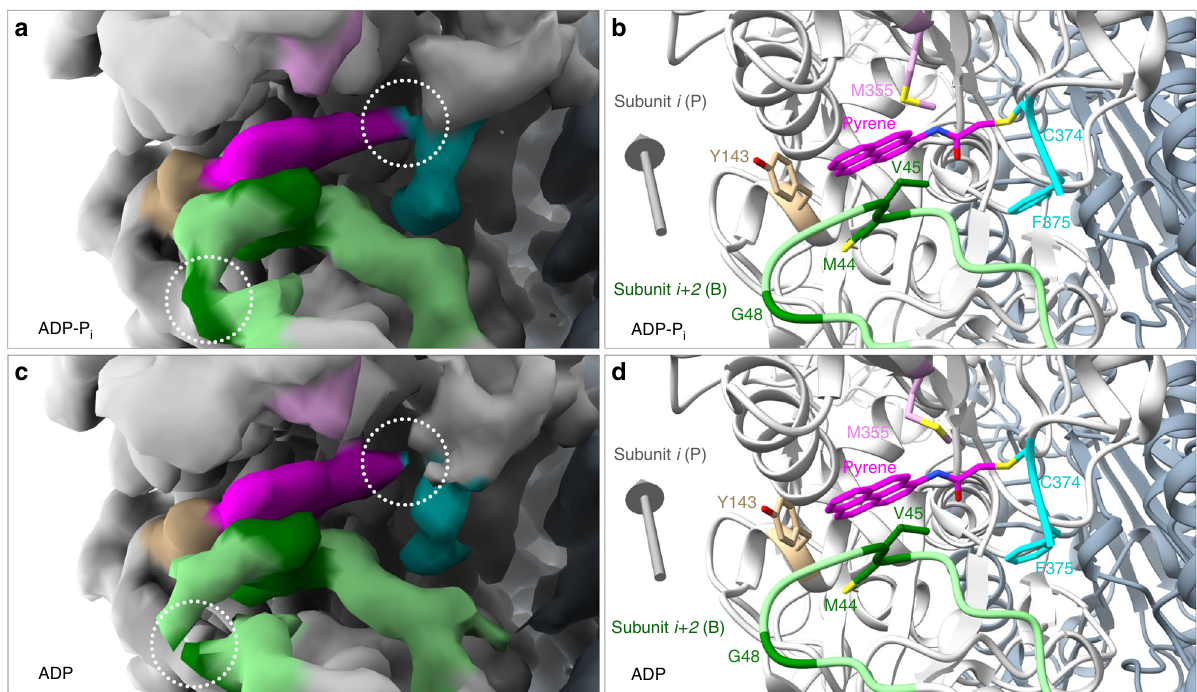
Fig. 5 Subtle differences in the pyrene and surrounding residues in (a, b) Mg-ADP-P i - and (c, d) Mg-ADP-pyrenyl-actin fi laments with map densities on the left and ribbon diagrams on the right. Both maps are contoured at the same level (0.015 V). Color code: actin subunits, light gray in one strand and slate gray in the other strand; D-loop (residues 40 – 50) of the adjacent actin subunit, light green with residues M44, V45, and G48, dark green; pyrene, magenta; C-terminus including C374 and F375, cyan; Y143, tan; M355, plum. Gray arrows are orientated with their heads pointing to the pointed end of the fi laments. In the ADP-actin fi lament ( c ), note the lower/broken density for G48 and the connection between pyrene and the side chain of